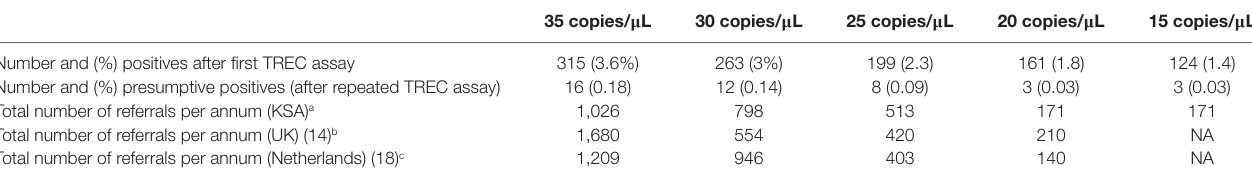
TaBle 2 | Comparison of number of needed referrals for confirmatory studies for severe combined immunodeficiency disease based on T cell receptor excision circle (TREC) concentration cutoffs.